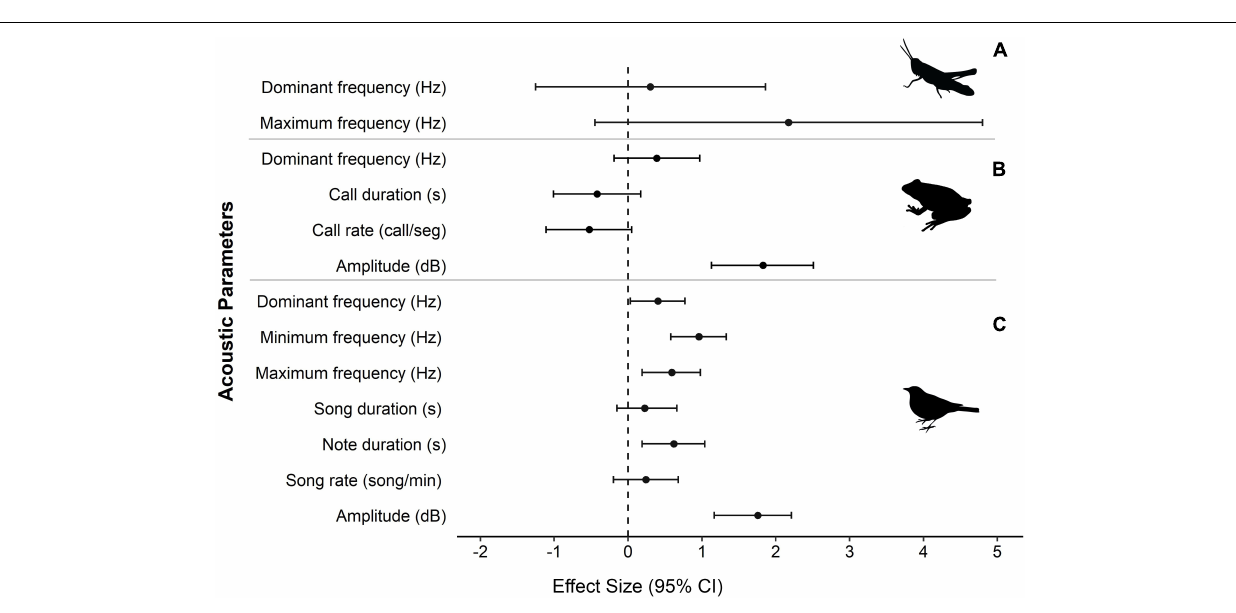
FIGURE 4 | Forest plot representing effect of anthropogenic sounds for acoustic parameters. The mean effect size Hedges’ g (represented by black circles) and confidence interval values of 95% (bars) for each acoustic parameter, separated by taxon, (A) Insects, represented by the orders Orthoptera and Hemiptera, (B) Anurans and (C)